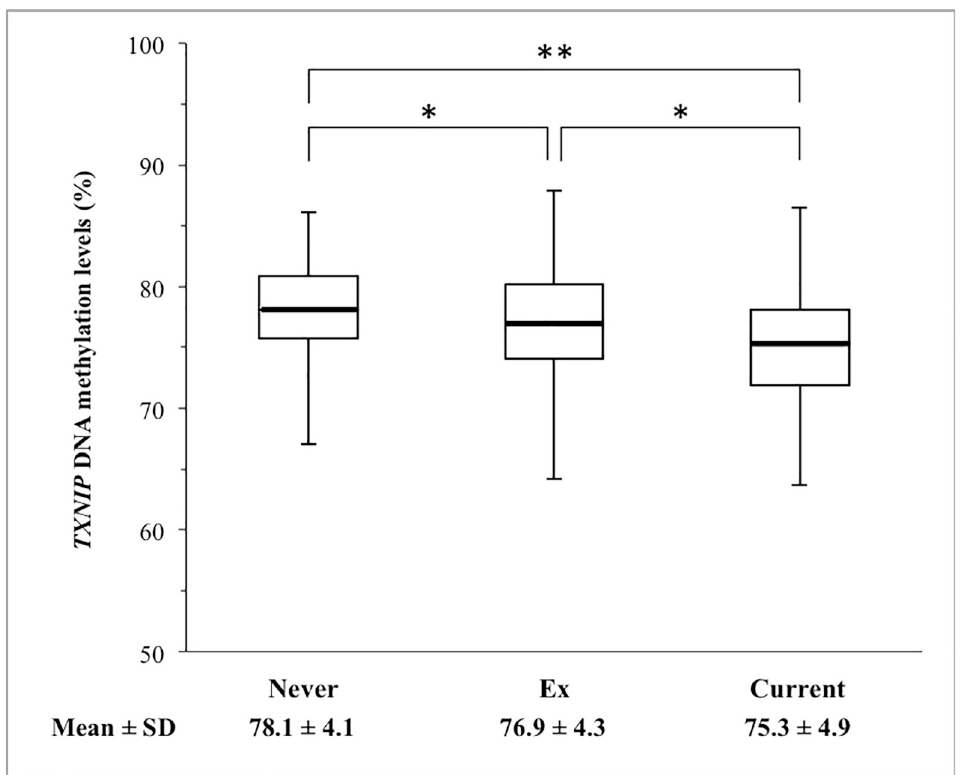
Fig 1. Comparison of TXNIP DNA methylation levels according to smoking habits. Boxplots (bold horizontal line: mean; box: interquartile range; upper whisker: maximum value; lower whisker: minimum value) of TXNIP DNA methylation levels in never smokers (n = 203), ex-smokers (n = 149), and current smokers (n = 65). � p < 0.05, �� p < 0.01 (Tukey-Kramer HSD tests).